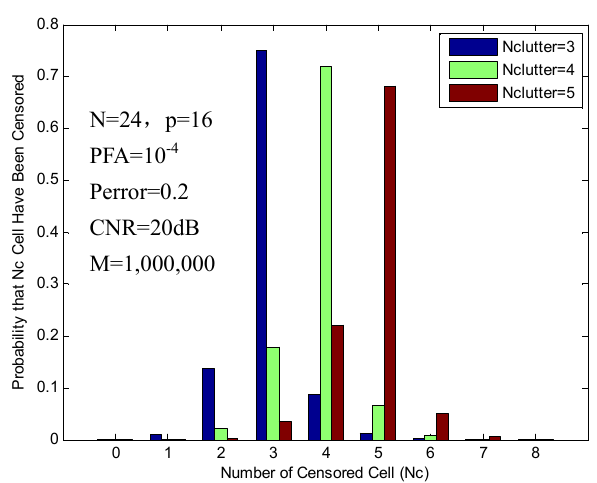
Figure 9. Probability of censoring in the clutter edge environment (3, 4 and 5 clutter cells).